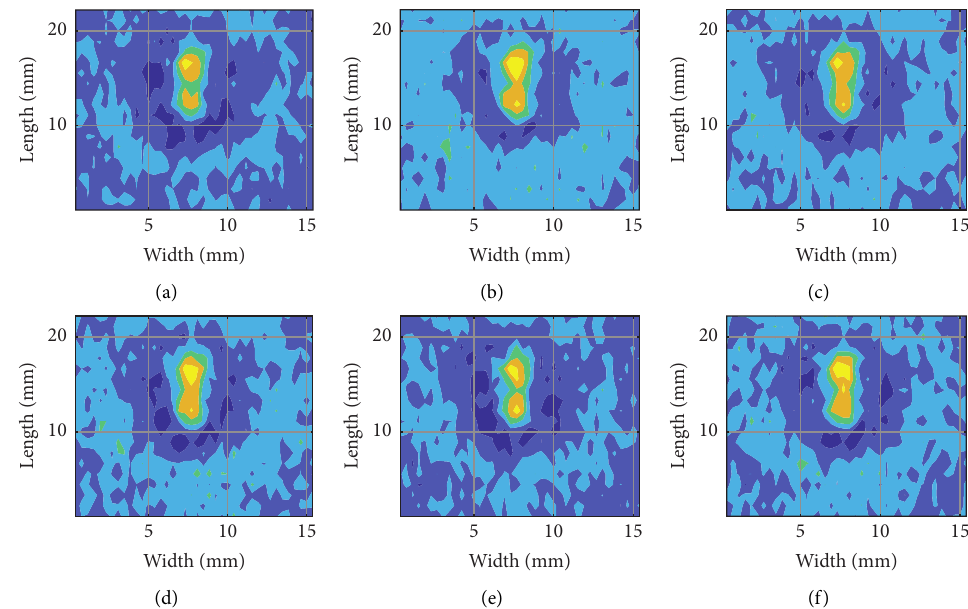
Figure 11: Real-part imaging of C5 defect with different noise effects. (a) SNR � 95dB. (b) SNR � 90dB. (c) SNR � 80dB. (d) SNR � 70dB. (e) SNR � 60dB. (f) SNR � 50